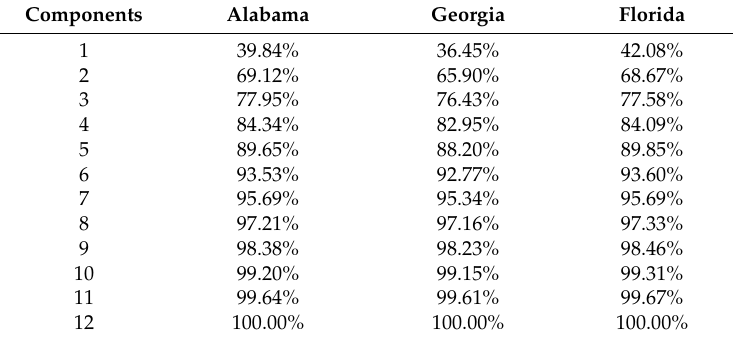
Table 2. Cumulative proportion of variation explained by each component for each state’s principal component analysis